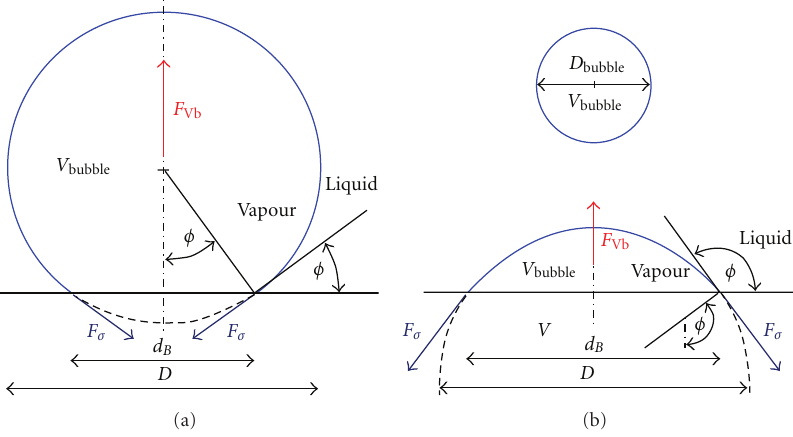
Figure 1: Spherical bubble in stagnant fluid on hydrophilic (a) and hydrophobic surface (b). D stands for virtual bubble (sphere) defined with vapour slug interface curvature while D bubble stands for bubble departure